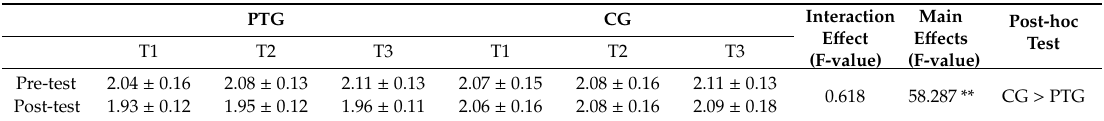
Table 4. Values are the mean ± standard deviation. Data are reported for the blocking agility (BA) test. The unit of BA is second (s). PTG CG